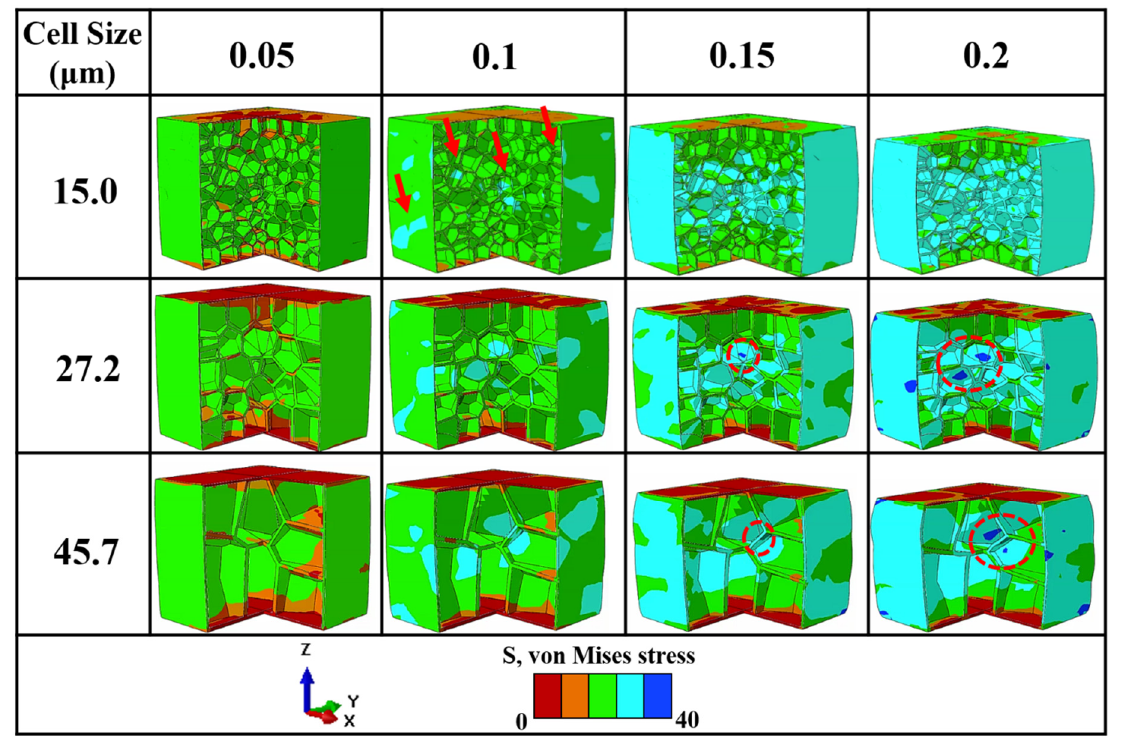
Figure 10. Three-dimensional (3D) stress contour maps for foams of the same porosity of 82% under quasi-static loading.